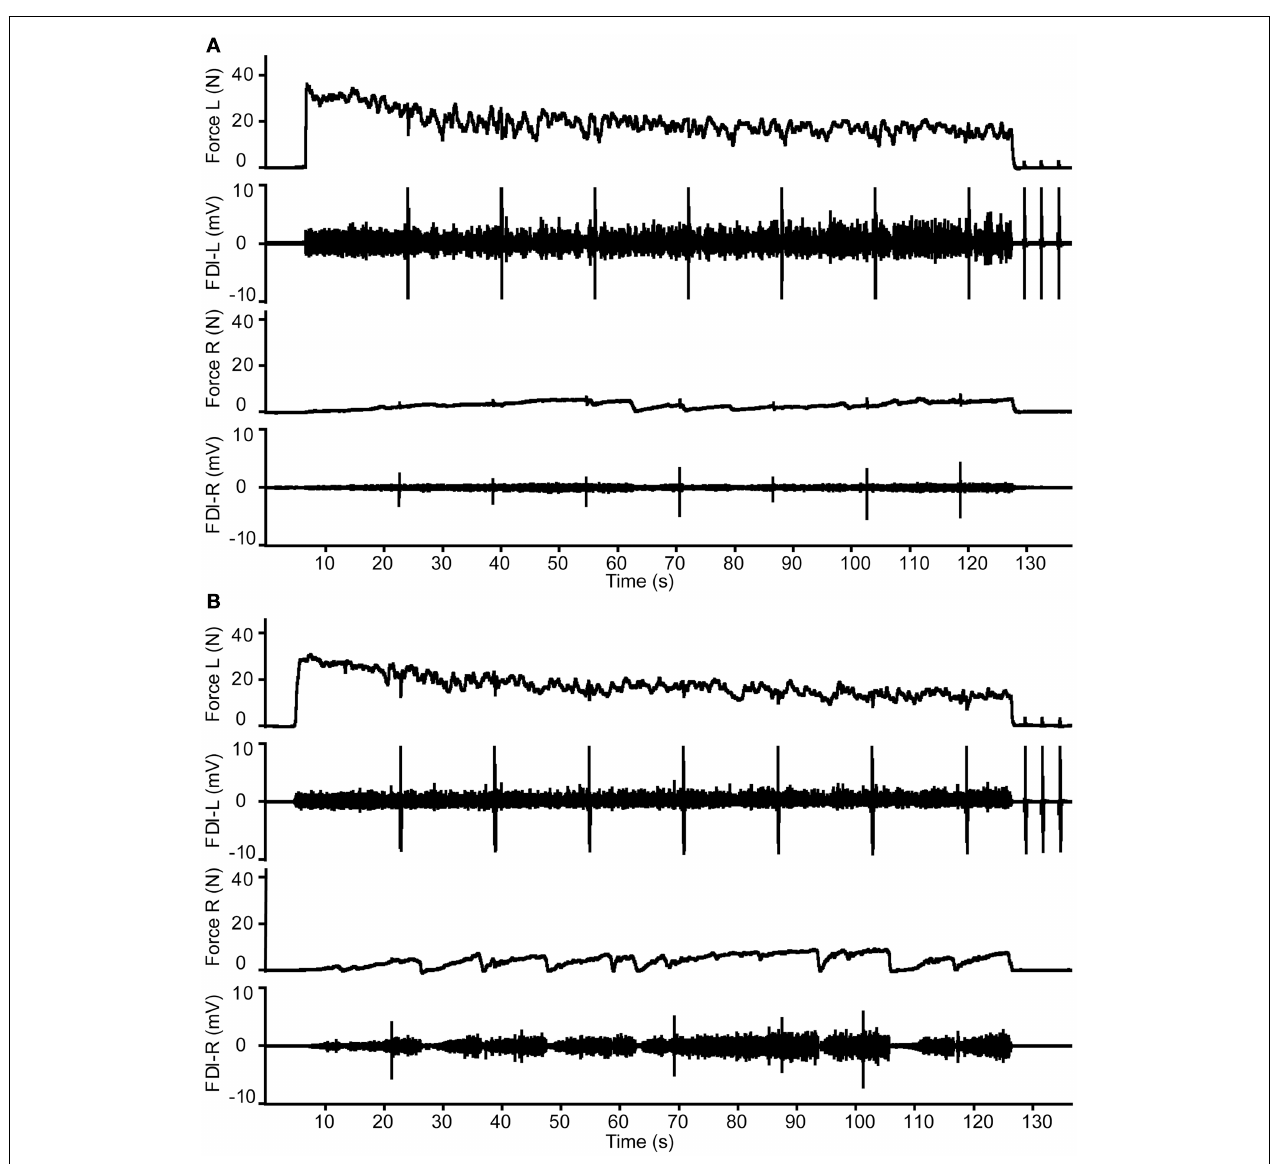
FIGURE 5 | Example of the changes in target and associated force and electromyography during the 2-min contraction with the FDI muscle of Hand-2 (left) in a young male (A) and middle-aged female participant (B) . Please note the stronger activity in right hand (Hand-1) in the middle-aged